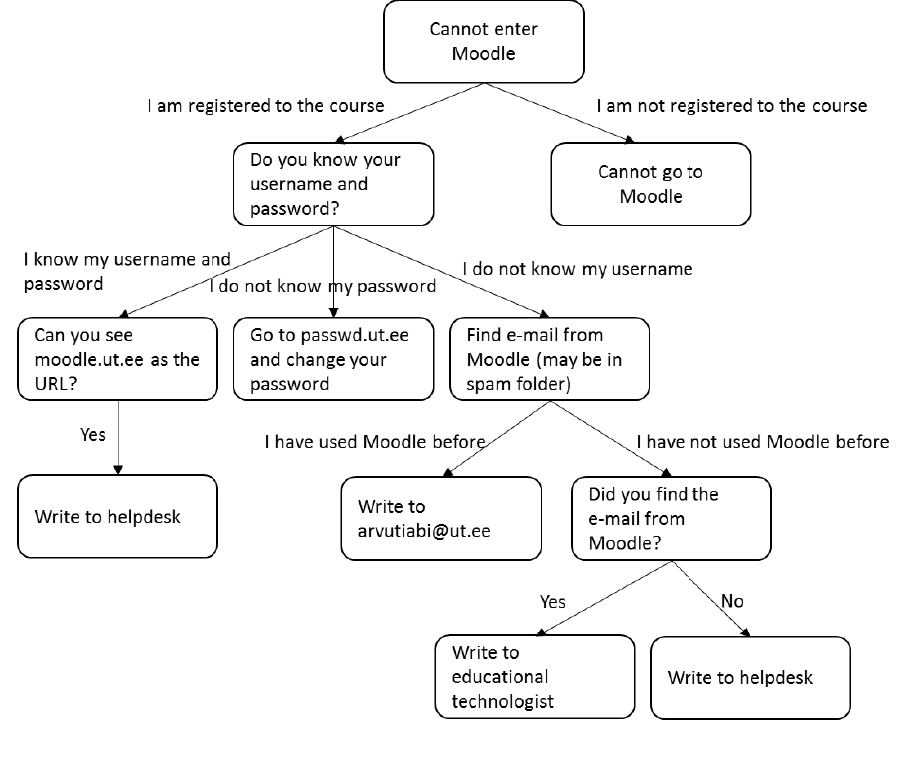
Figure 7 . Example of